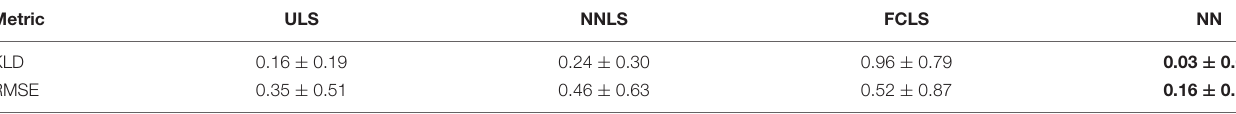
TABLE 2 | Unmixing algorithms and their performance in terms of Kullback–Leibler divergence (KLD) and root mean squared error (RMSE). Metric